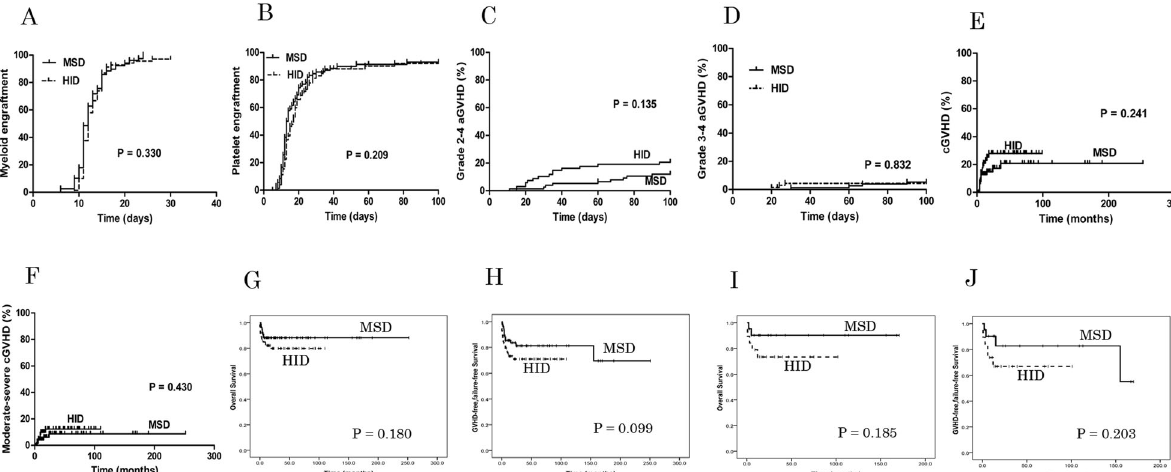
Fig. 1 The cumulative incidence of engraftment, graft-versus-host disease (GVHD), overall survival (OS) and GVHD failure-free survival (GFFS). A The cumulative incidence of 30-day engraftment was 97.10% ± 2.02% and 100.00 %± 0.00% in the HID and MSD groups, respectively ( P = 0.330). B The cumulative incidence of platelet engraftment was 92.07% ± 3.56% and 97.69% ± 2.14% in the HID and MSD groups ( P = 0.209). C The cumulative incidence of grade 2 – 4 aGVHD on day + 100 was 20.59% ± 4.90% and 11.92% ± 3.73% after the HID and MSD transplants, respectively ( P = 0.135). D The cumulative incidence of grade 3-4 aGVHD on day + 100 was 4.39% ± 2.48% and 5.30% ± 2.58% after the HID and MSD transplants, respectively ( P = 0.832). E The cumulative incidence of cGVHD was 27.96 %± 6.11% and 20.86% ± 5.86% in the HID and MSD groups, respectively ( P = 0.241). F The cumulative incidence of moderate-severe cGVHD was 12.31% ± 4.45% and 8.73% ± 3.88% ( P = 0.430). G The probability of three-year OS was 79.7% ± 4.9% and 88.2% ± 3.7% after the HID and MSD transplants, respectively ( P = 0.180). H) The probability of three-year GFFS was 71.0% ± 5.6% after a HID transplant and 81.2% ± 4.9% after a MSD transplant ( P = 0.099). I In patients ≥ 40 years old, there was no difference in estimated three-year OS between the HID and MSD groups (73.3% ± 10.2% vs. 90.2% ± 6.6%, respectively P = 0.185). J In patients ≥ 40 years old, there was no difference in estimated three-year GFFS between the HID and MSD groups (67.0% ± 11.2% vs. 82.7% ± 9.4%, P =